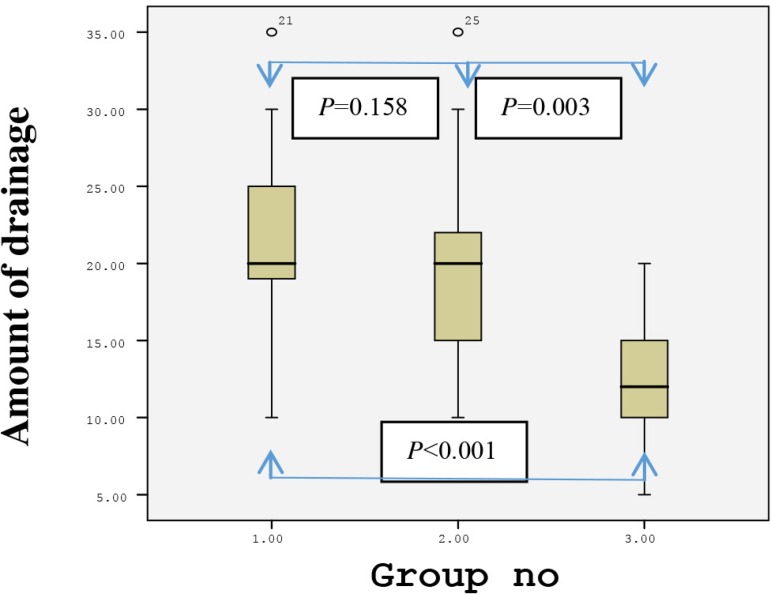
Distribution of 24-hour drainage amount between the groups.Group 1=classical method (using sharp dissection); Group 2=electrocautery; Group 3= ultrasonic cautery